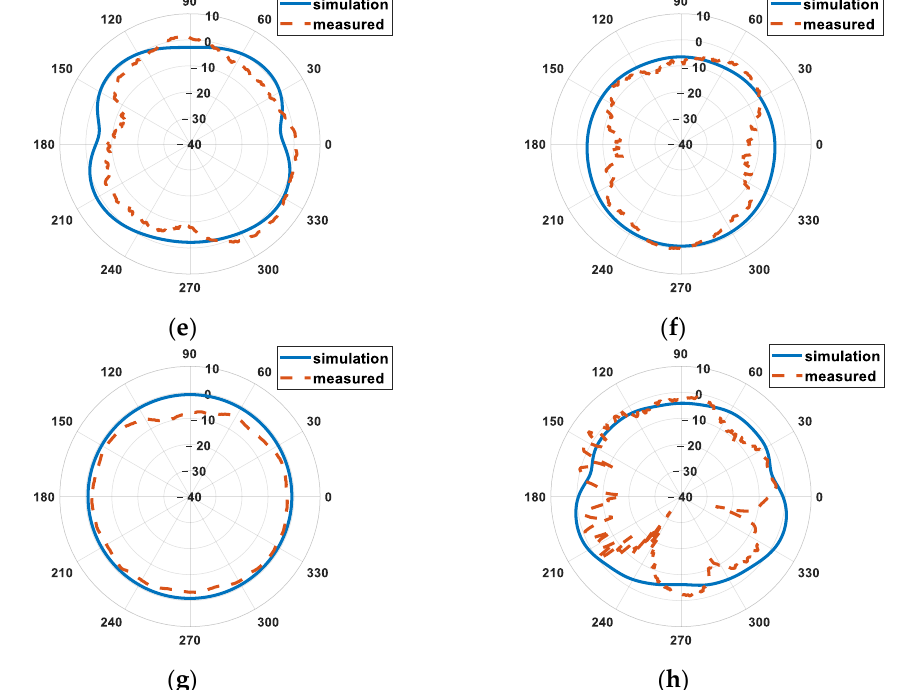
Figure 12. Comparison of the antenna 2D radiation pattern between measurement and simulation. ( a ) E-plane at 2.4 GHz; ( b ) H-plane at 2.4 GHz; ( c ) E-plane at 3.5 GHz; ( d ) H-plane at 3.5 GHz; ( e ) E-plane at 6.3 GHz; ( f ) H-plane at 6.3 GHz; ( g ) E-plane at 10 GHz; ( h ) H-plane at 10 GHz.